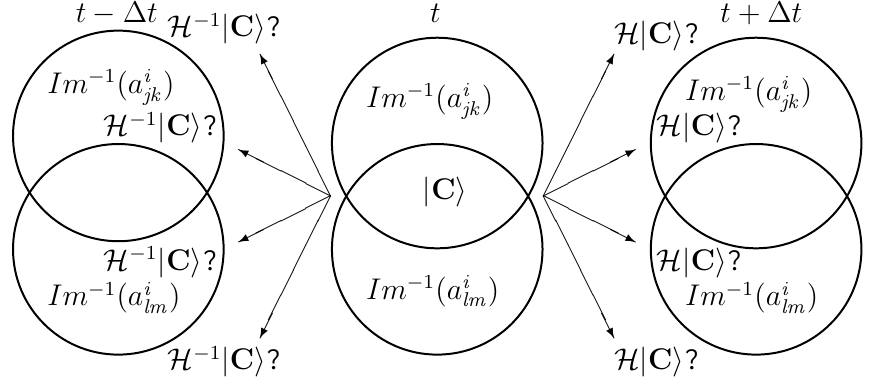
Figure 6. Dynamic evolution of at t